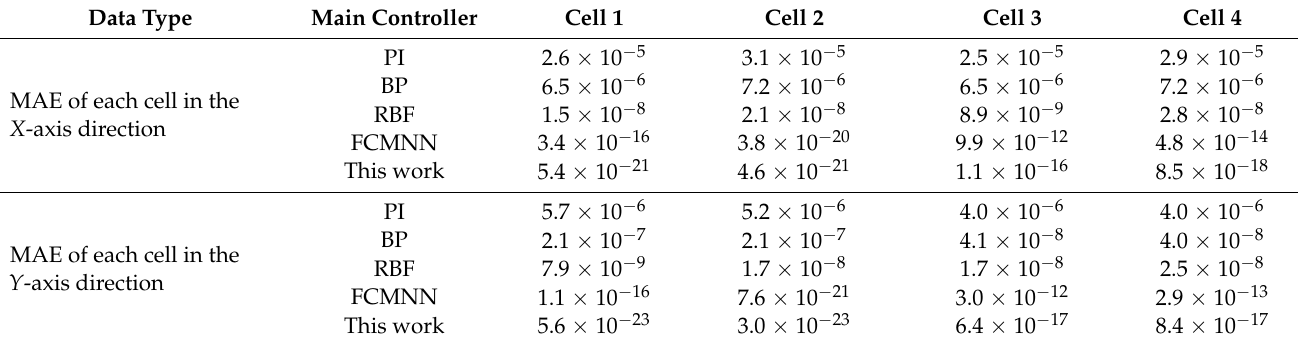
Table 5. MAE of each